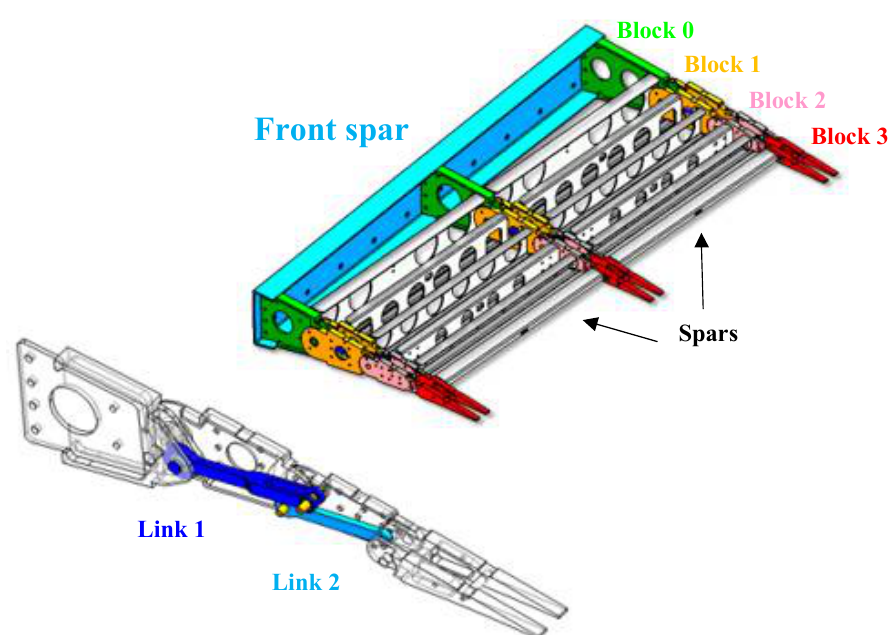
Figure 2. Multi-segment structure concept.